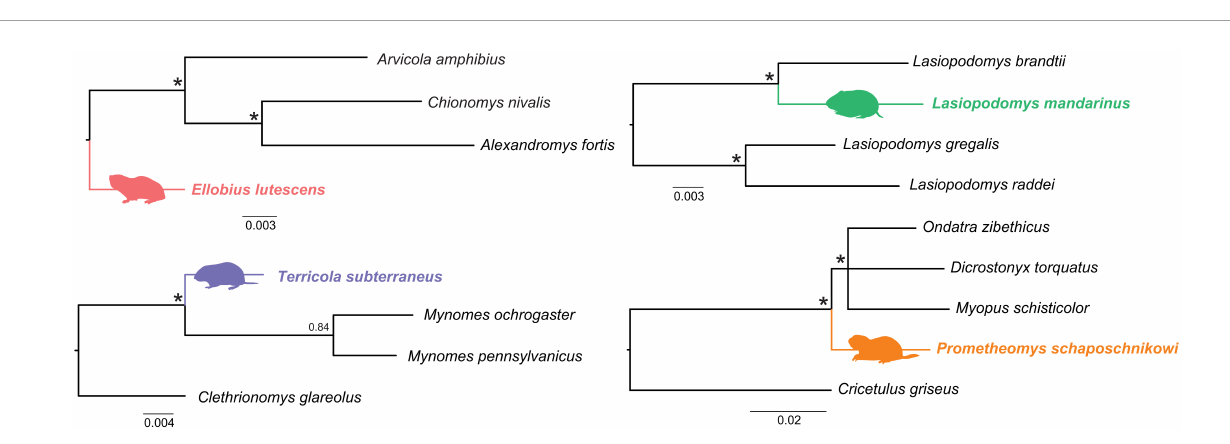
FIGURE2 Trees used for tracing signatures of the selection pressures on the subterranean vole species. Fifty-percent majority rule consensus trees from Bayesian inference analysis are given. Subterranean species are shown in color. Nodes with 0.99–1.0 BI support are indicated with